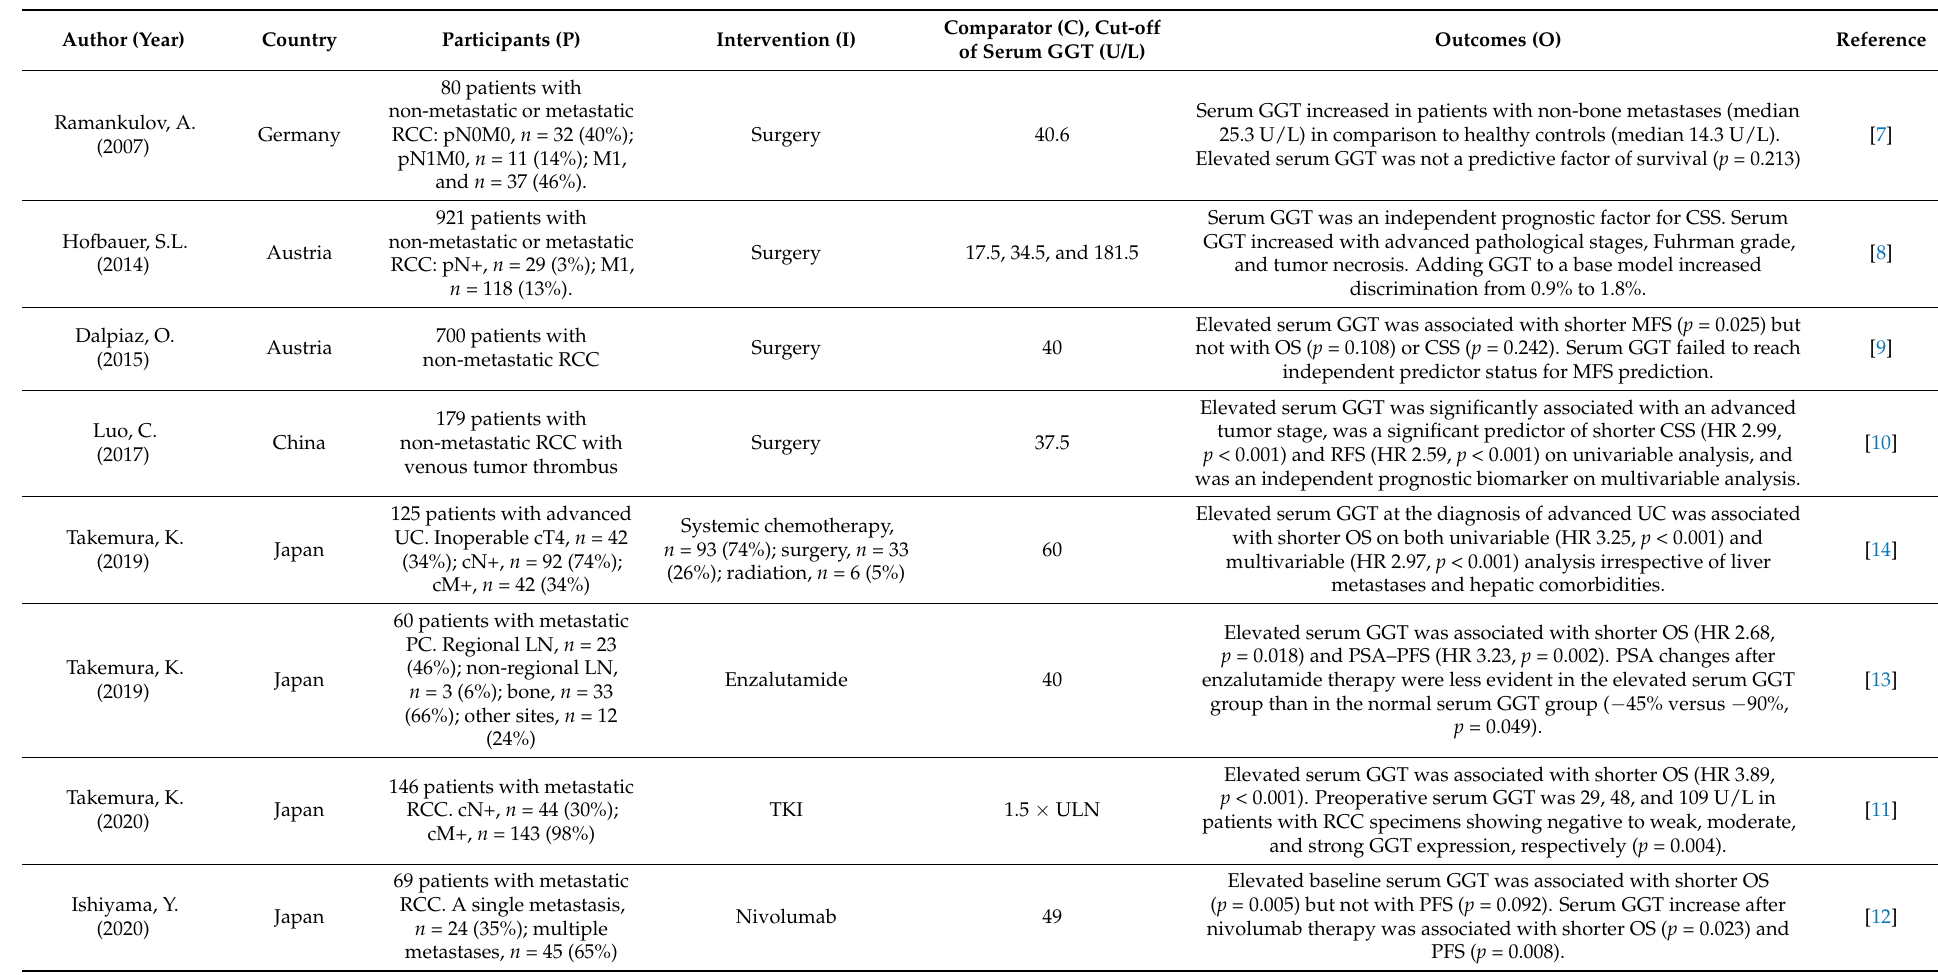
Table 1. Previous literature on serum γ -glutamyltransferase as a prognosticator in patients with genitourinary